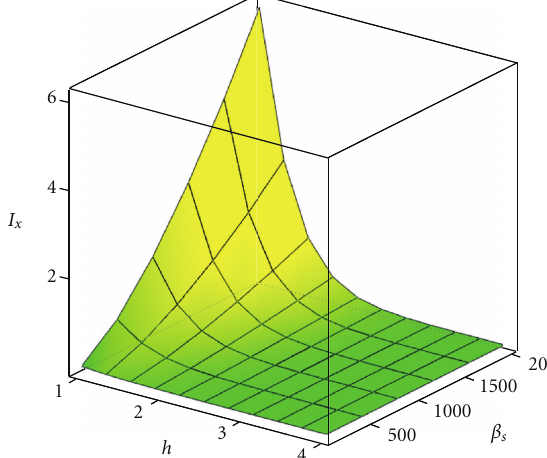
Figure 8: I x ( h , β s ) for w c = 100 ( ψ = 0 . 1), Elastic